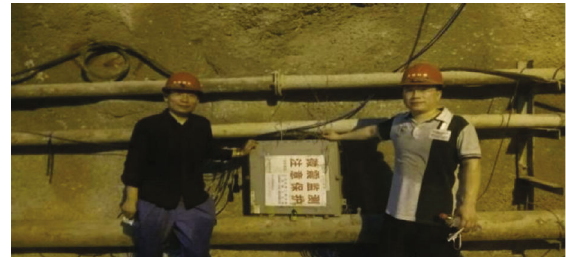
Figure 21: The data acquisition instrument (Paladin) is installed at the No. 4 branch tunnel of the Qinling Mountains of Han to the Wei River project in Shaanxi